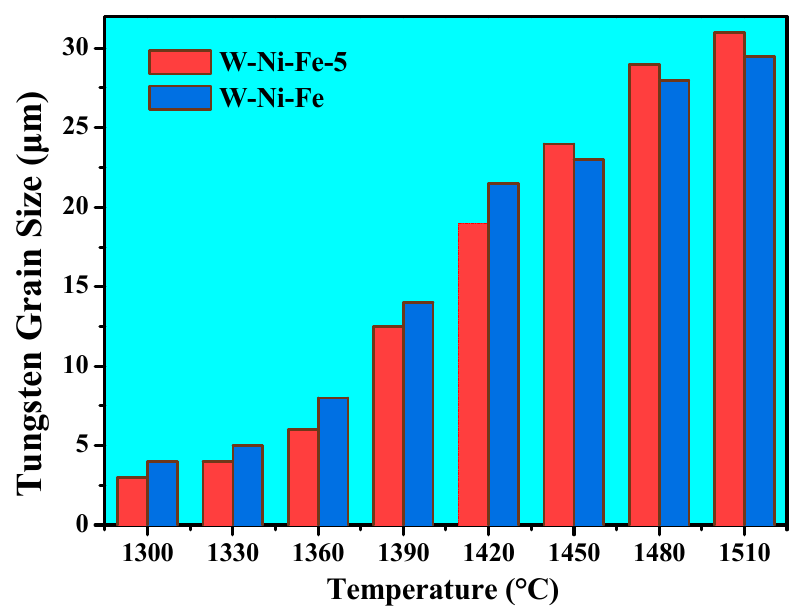
Figure 10. Average tungsten grain sizes changing with sintering temperature. Majumdar et al. [15] reported the preparation of W-2Ni-1Fe alloy from micro-scaled powder using die pressing subsequent with liquid phase sintering, their results show that this material has a tensile strength of about 850 MPa, and tungsten grain size of 25–40 µ m, at the optimized sintering temperature of 1500 ◦ C. As a comparison, the 98W-1Ni-1Fe alloy prepared by PEP method in this study can reach an equivalent mechanical performance at a much lower sintering temperature and tungsten grain size (~15 µ